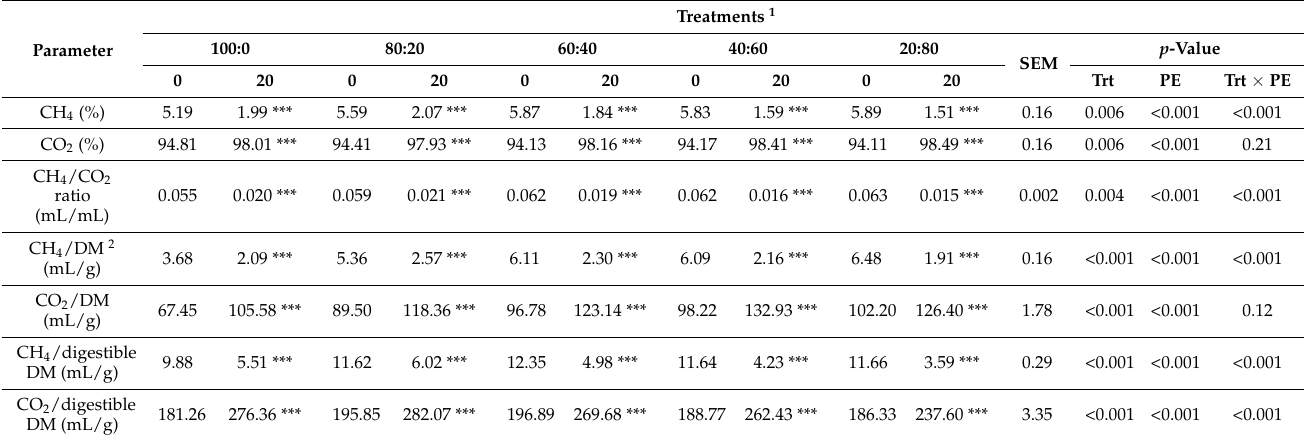
Table 3. Effect of plant-bioactives extract (PE) supplementation on CH 4 and CO 2 production in different feeding styles after 24 h In Vitro incubation ( n = 18).